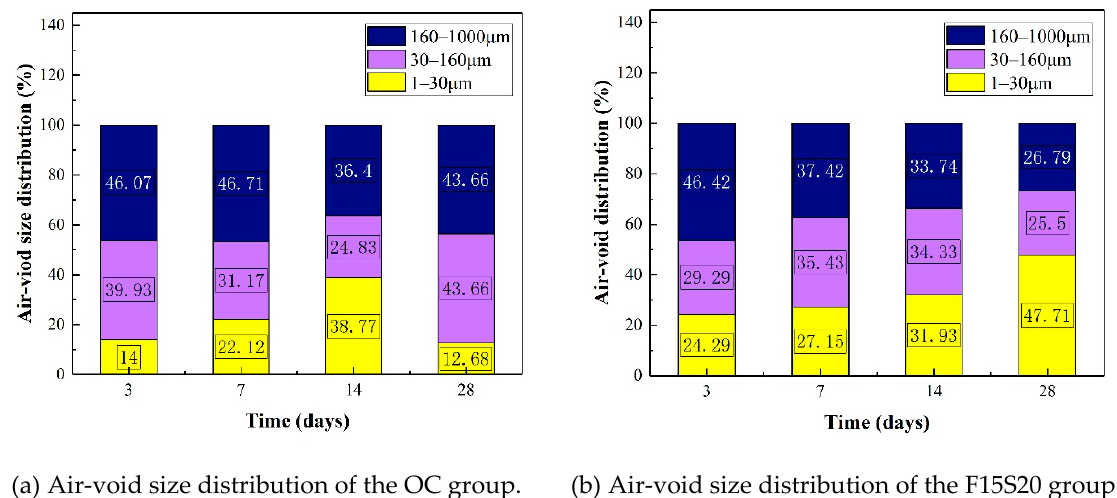
Figure 14. Pore diameter distribution of concrete at different ages: ( a ) the OC group; ( b ) the F15S20 group.